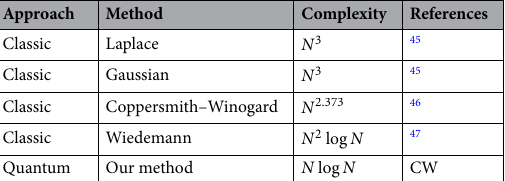
Table 1. A Comparison of complexities between the classical approaches and our quantum approach, current work (CW), for the computation of determinant.